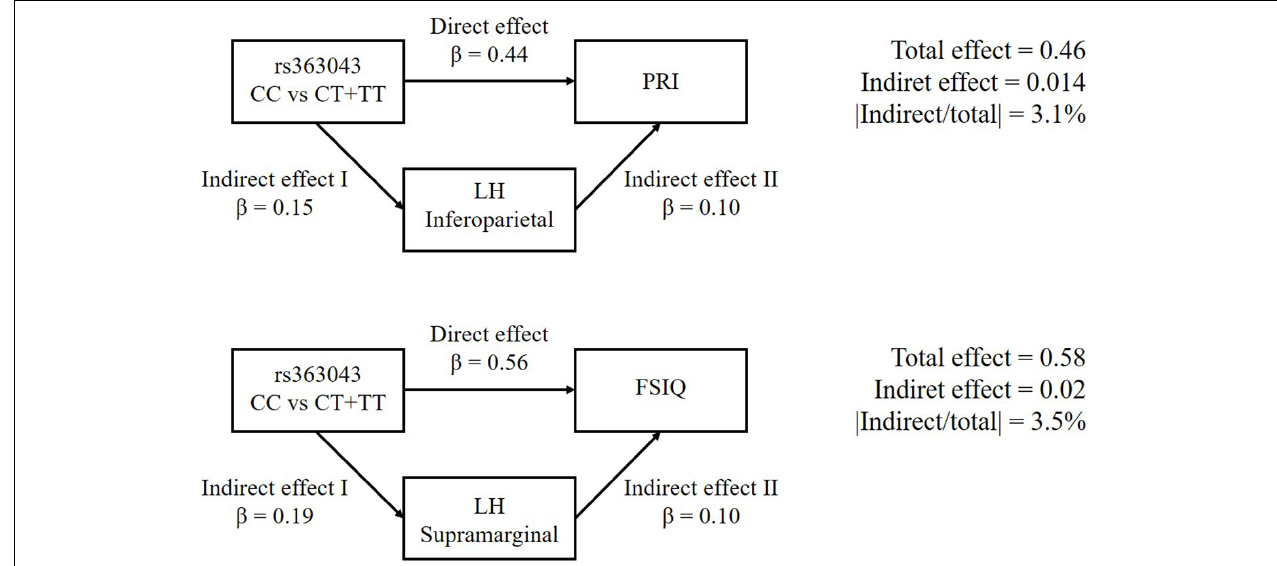
FIGURE 2 | Causal mediation analyses of SNAP-25 rs363043 on PRI and FSIQ scores of the WISC-III/IV. The Left inferoparietal and supramarginal cortex thickness as the mediators for PRI and FSIQ, respectively. The Left inferior parietal and supramarginal cortex thickness were observed to be the mediators for PRI and FSIQ, respectively. The upper part of the figure shows the association of the rs363043 polymorphism with PRI score (direct effect = 0.44; contribution of the left inferior parietal = 3.1%). The lower part of the figure shows the association of the rs363043 polymorphism with FSIQ score (direct effect = 0.56; contribution of the left Supramarginal gyrus =